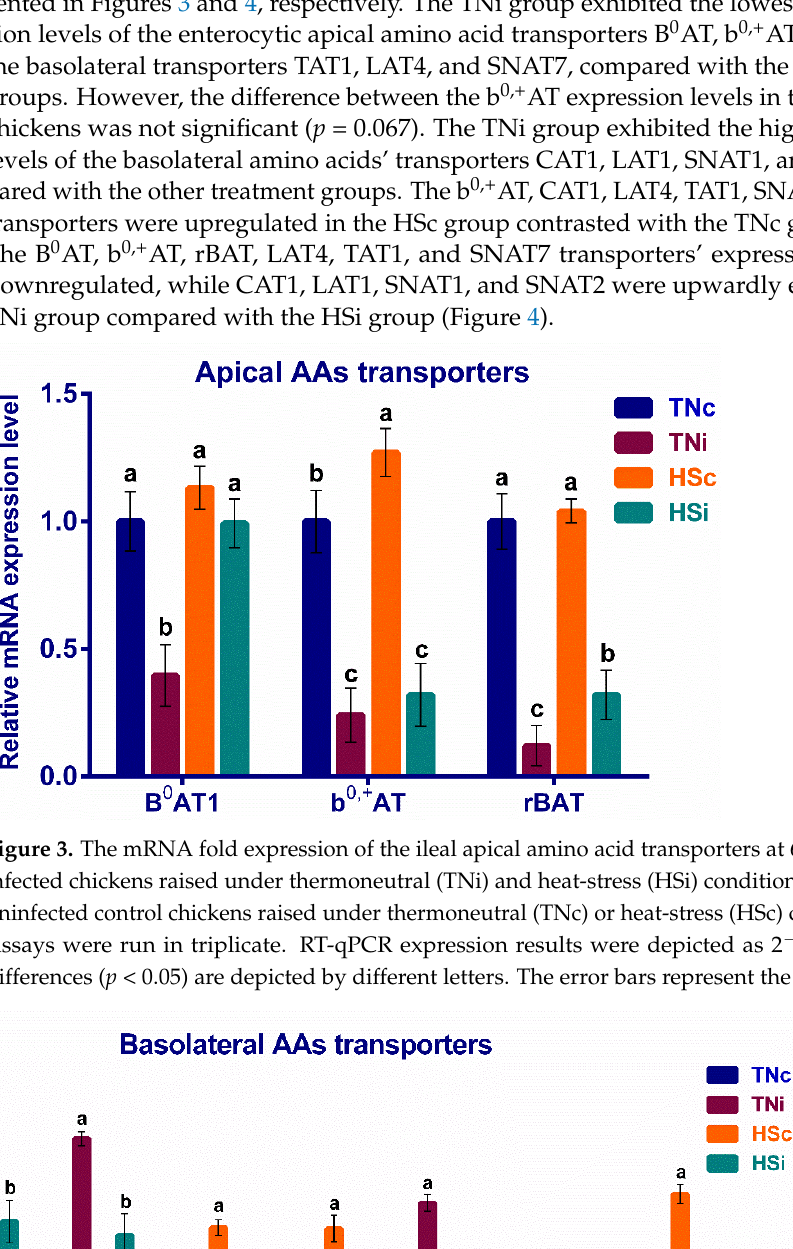
Figure 2. The apparent ileal digestibility of the non-proteinogenic amino acids ( A ) and sulphonic acids ( B ) at 6 dpi of E. maxima -infected chickens raised under thermoneutral (TNi) and heat-stress (HSi) conditions, as compared to uninfected control chickens raised under thermoneutral (TNc) or The error bars represent the SEM.